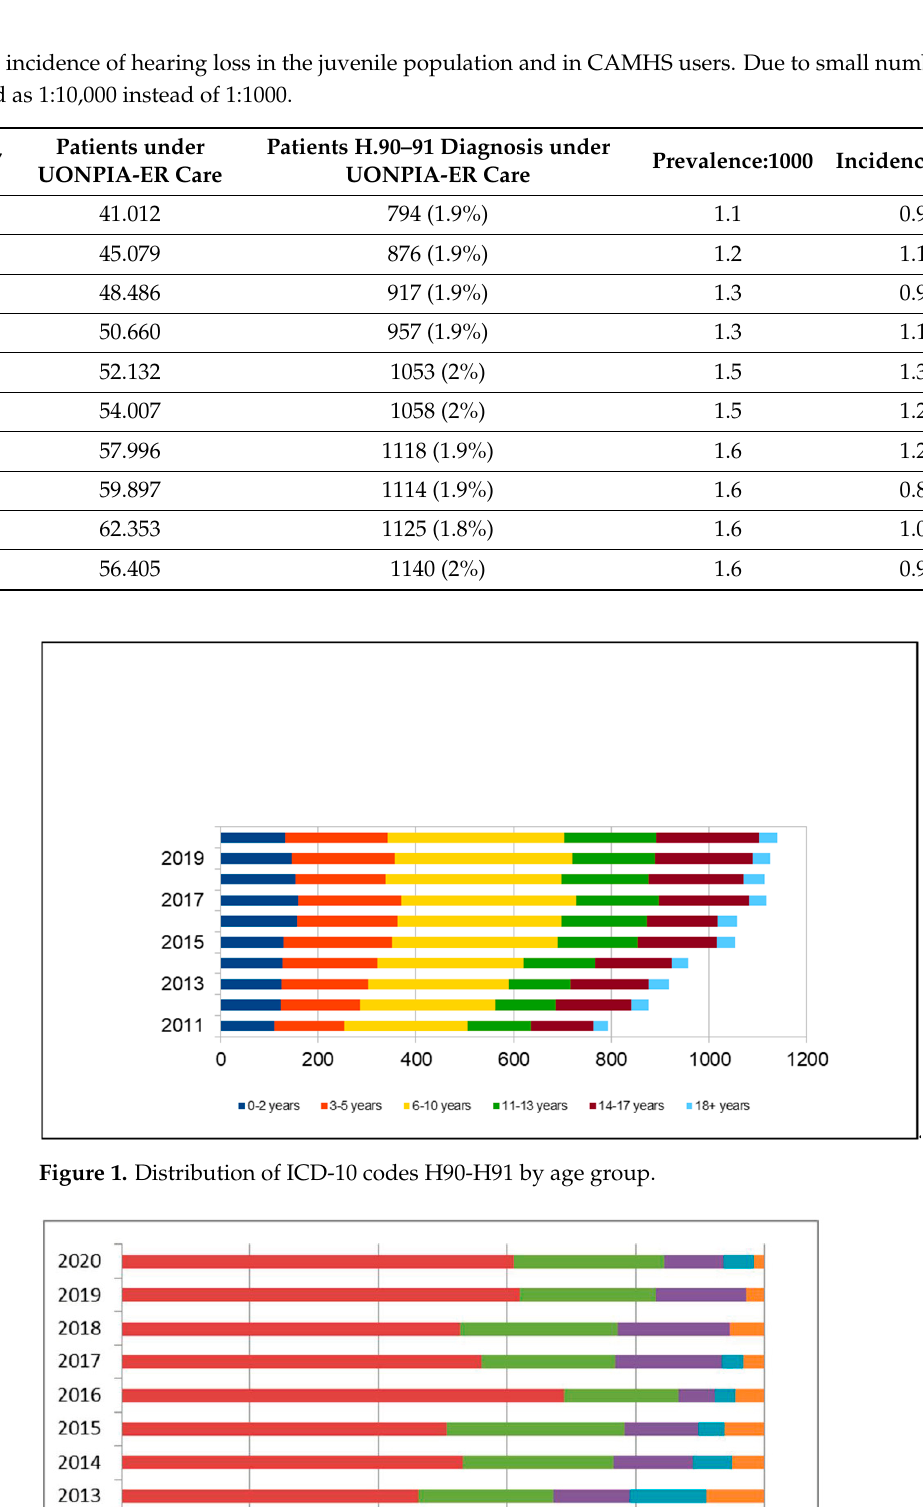
. Figure 3. New diagnosis at CAMHS (codes H90–H91) per year. Subjects affected by hearing loss, subdivided according to ICD 10th classification into further subtypes H90–H91, are indicated in Table 3 and in Figure 4. The most frequent type of hearing loss was bilateral sensorineural hearing loss (code H90.3), which occurred in 69–72% of cases, while bilateral conductive hearing loss (H90.2) was the second most common type, ranging from 8 to 10%. Over the years, the use of the generic code H90, without further specification, dropped drastically, from 8% to 1%.